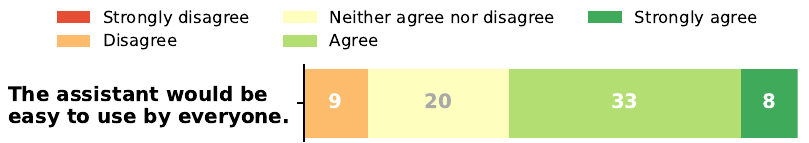
Figure 6. Results for the question on whether the assistant would be easy to use by everyone.